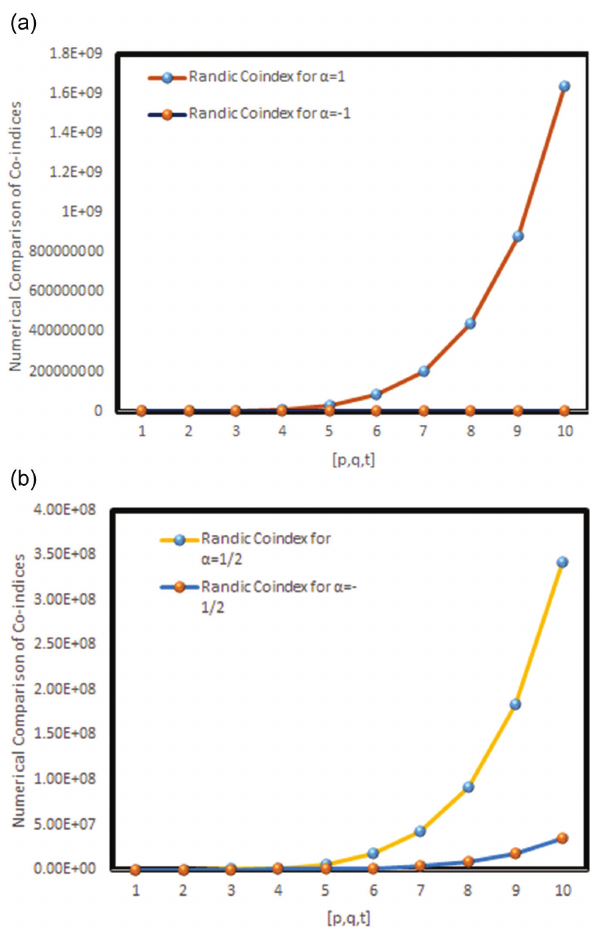
Figure 4: Comparison of: (a) −